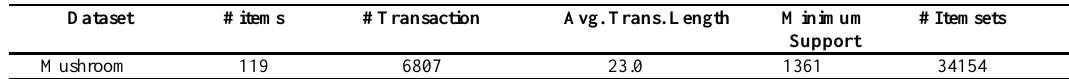
Table 5. Characteristics of the Mushroom